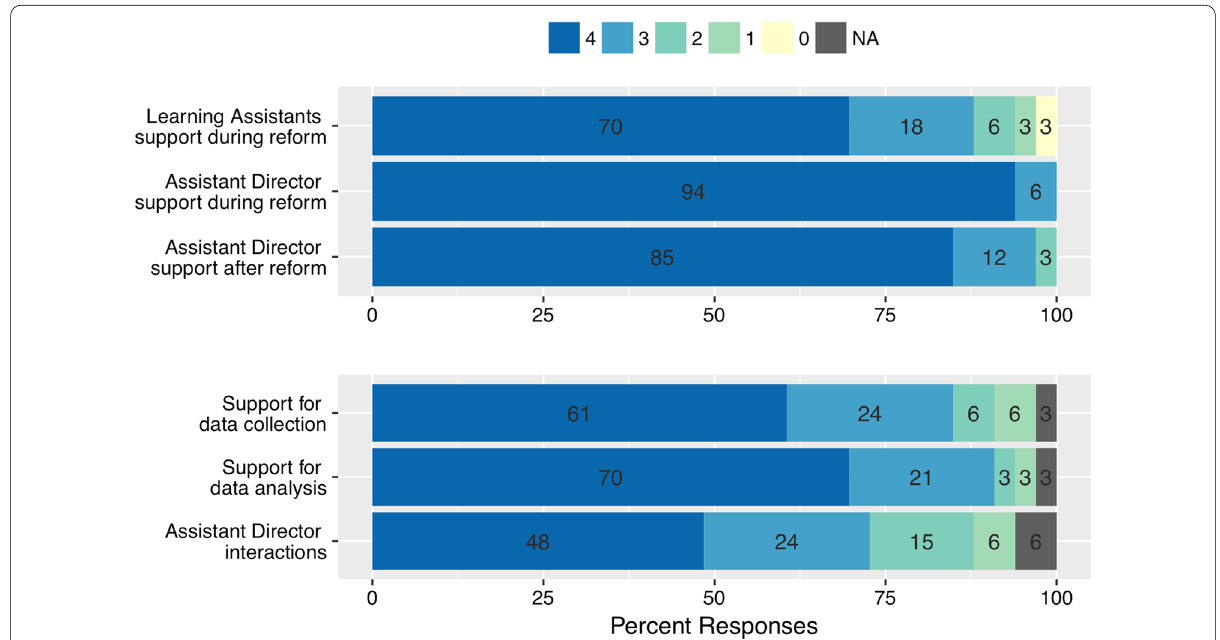
Fig. 3 CISL Personnel Program Support. Percent of Faculty Scholars reporting their perceptions on the extent of the benefit of certain programmatic elements stemming from the Assistant Director or Learning Assistant support. Faculty responses were recorded on an anchored 5-point rating scale, with rating 4 indicating highest importance (i.e., “very important”) and rating 0 indicating lowest importance (i.e., “not at all important”). Numbers superimposed in the bars are the percentage of respondents choosing that option ( N